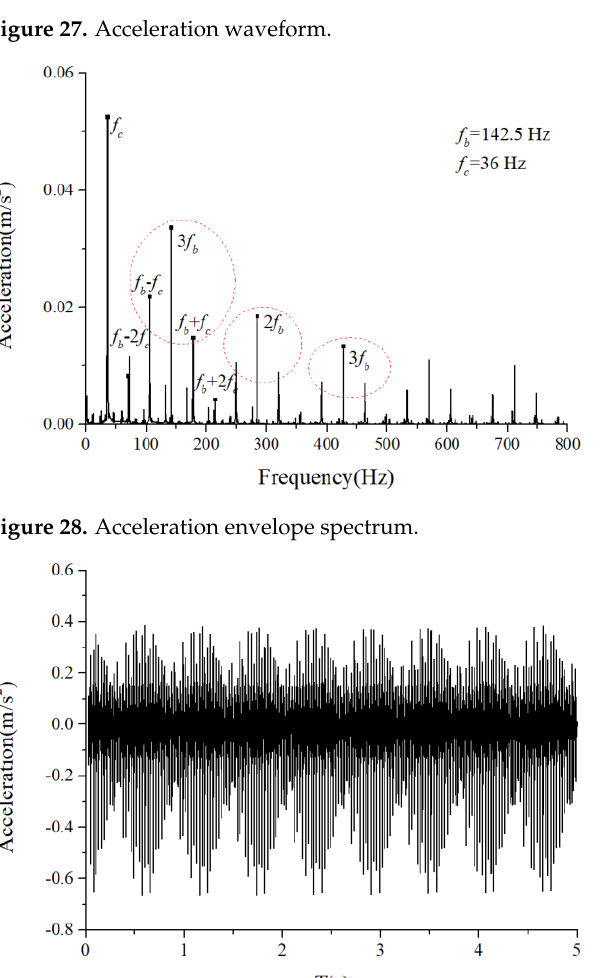
Figure 30. Acceleration envelope spectrum. Figure 31. Acceleration waveform.